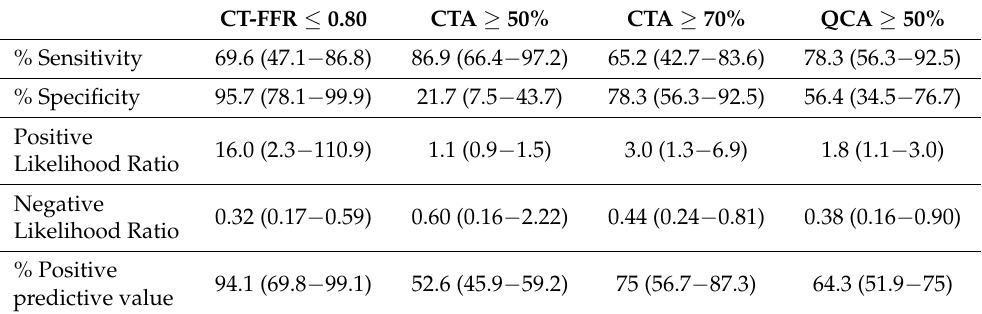
Table 3. Diagnostic performance of CT-FFR, CTA and QCA to identify RFR ≤ 0.89 on a per vessel basis. CT-FFR ≤